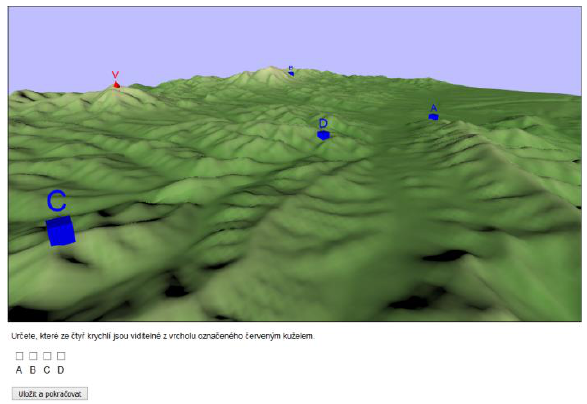
Fig. 3. Determination of visibility (task 3, interactive variant)